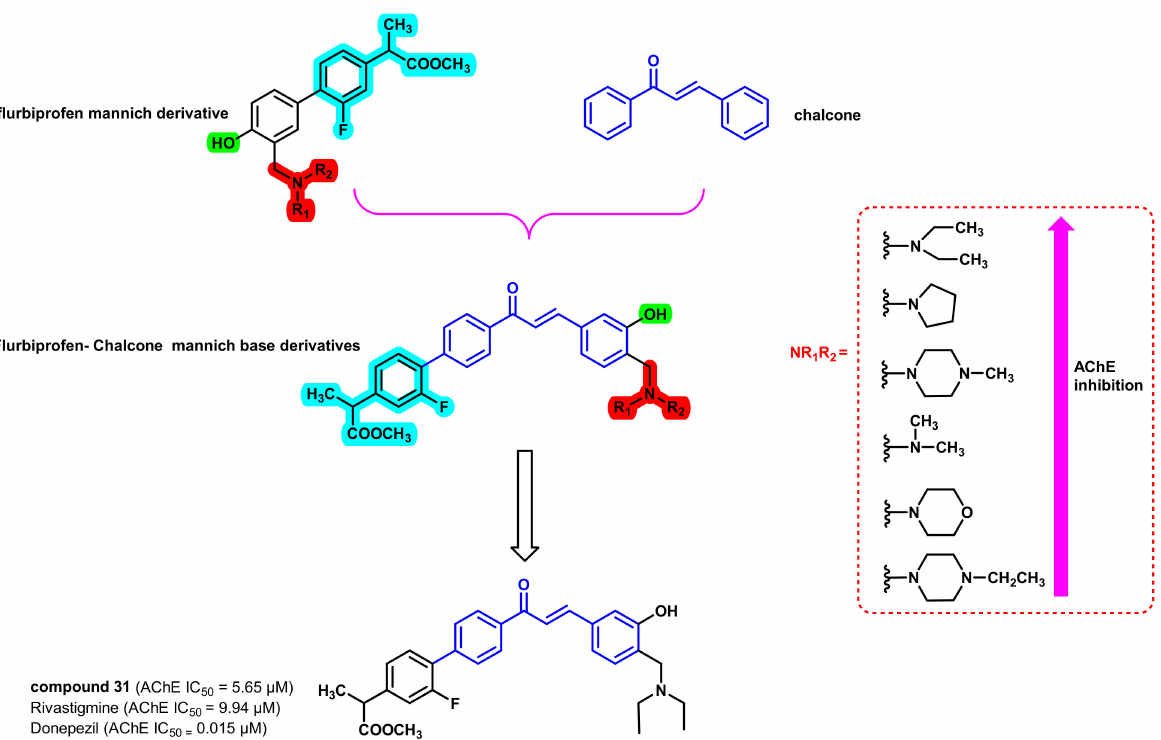
Figure 28. Chemical structures of flurbiprofen Mannich derivative–chalcone hybrid derivatives. Tran et al., synthesized a series of N -substituted-4-phenothiazine-chalcones and